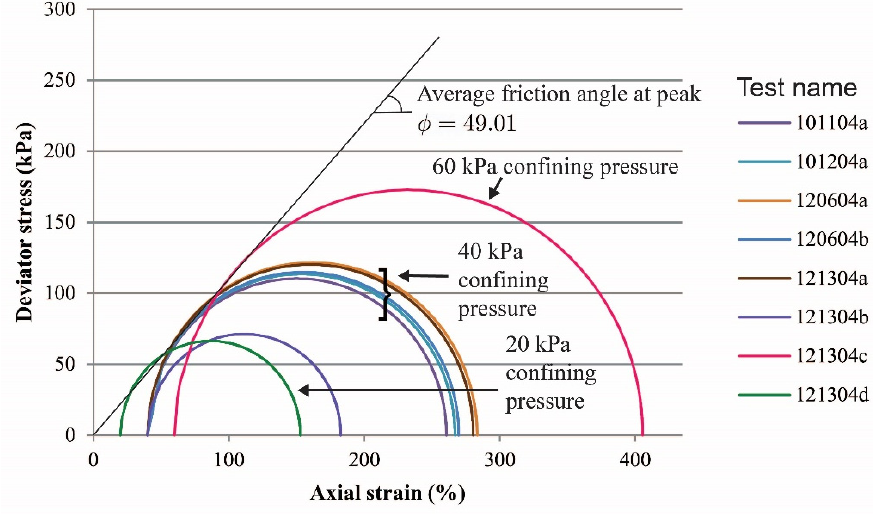
Figure 6 . Mohr’s circles of sand specimens prepared by the dry pluviation method. Figure 6. Mohr’s circles of sand specimens prepared by the dry pluviation